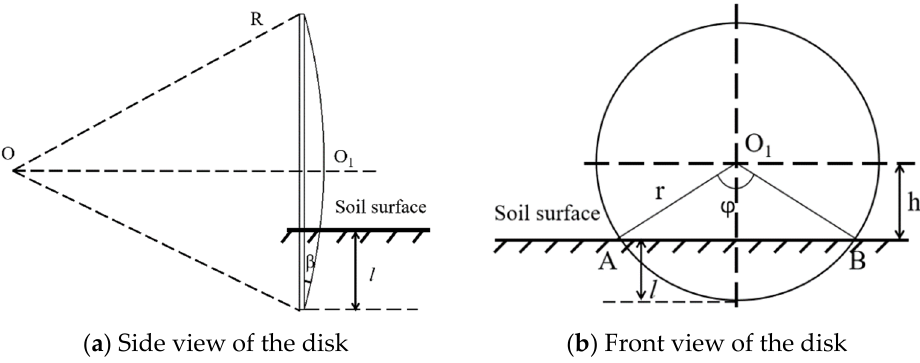
Figure 5. The contact area between covering disk and soil. According to formula (1), the soil contact area is related to the disk diameter, V- shaped angle, and the depth of the disk in soil. To find out the related factors about the amount of soil covering, the movement trajectory of contact soil particles was analyzed (Figure 6). Because the soil humidity is low in its planting, the adhesion between soil particles is negligible. According to the dynamic analysis, the following formulas can be obtained: